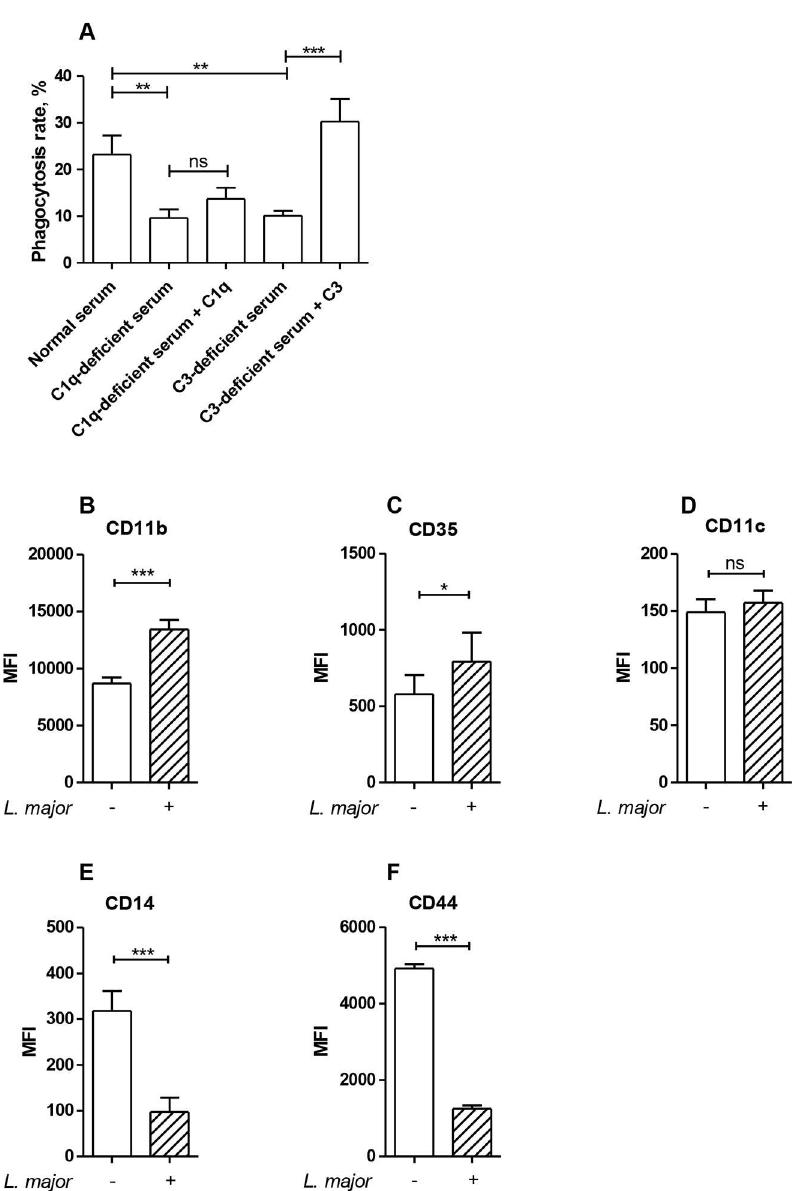
Fig 2. Complement factors are necessary for efficient neutrophil-mediated phagocytosis of apoptotic cells. Neutrophils were co-incubated with apoptoticcells in the presenceof 30% normalhumanserum, C1q- depletedor C3-deficient serum with or withoutreconstitution of the deficientsera with exogenous C1q or C3, respectively. Phagocytosis of apoptoticcells was assessed by flow cytometry. Data are shownas mean ± SEM of four independentexperiments (A). Neutrophils were infectedwith L . major promastigotes (ratio of 1 to 10) for 4 h at 37˚C. Surfaceexpressionof CD11b(B), CD35 (C), CD11c(D), CD14 (E), and CD44 (F) was assessed by flow cytometry. Data are shownas mean ± SEM of three to seven independent experiments. * p (cid:20) 0.05, ** p (cid:20) 0.01, *** p (cid:20) 0.001, ns = not